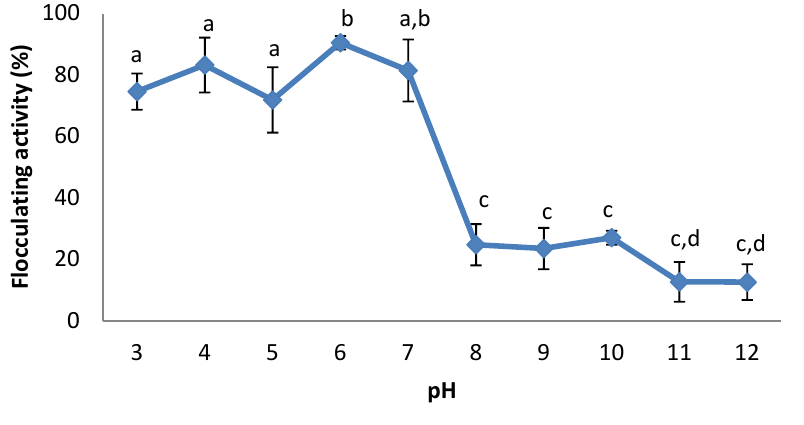
Figure 4. Effect of initial pH on bioflocculant production of Cobetia sp. OAUIFE. Flocculating activities with different letters are significantly different ( p < 0.05) from each other.